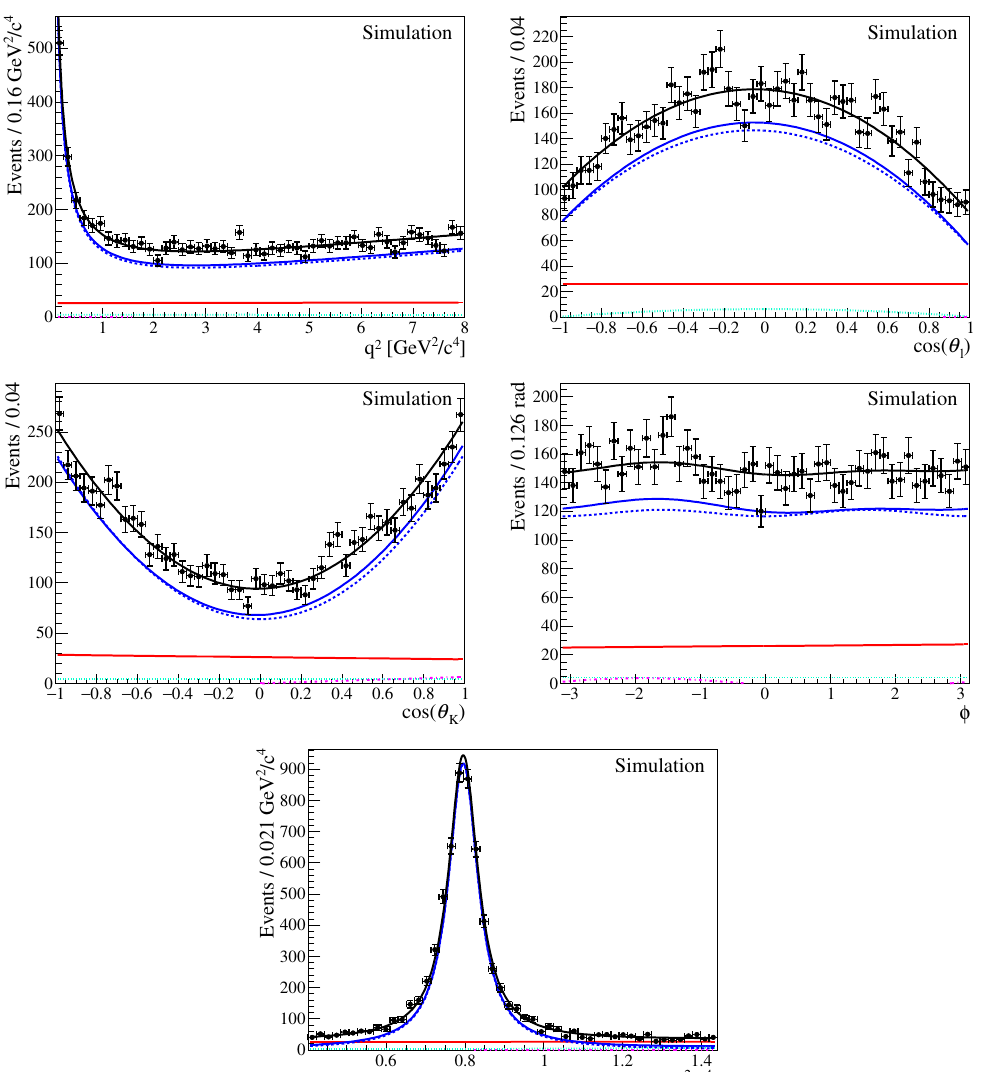
Figure 4. Results from the (cid:12)t of a single pseudoexperiment varying the Wilson coe(cid:14)cients Re( C 7 ) and Re( C 9 ). Simulated events are overlaid with projections of the (cid:12)tted PDF on q 2 , the three decay angles cos (cid:18) l , cos (cid:18) K and (cid:30) and m 2 in the q 2 range 0 : 1 < q 2 < 8 : 0 GeV 2 =c 4 . The simu- K(cid:25) lated events and projections are shown for the signal region (cid:6) 50 MeV =c 2 around the B 0 mass to enhance the signal fraction. The black solid line denotes the full PDF, the blue solid line the sig- nal component. The blue dashed line gives the P-wave and the teal dotted line the S-wave part. The magenta dash-dotted line (cid:12)nally gives the P-wave/S-wave interference and the red line the background